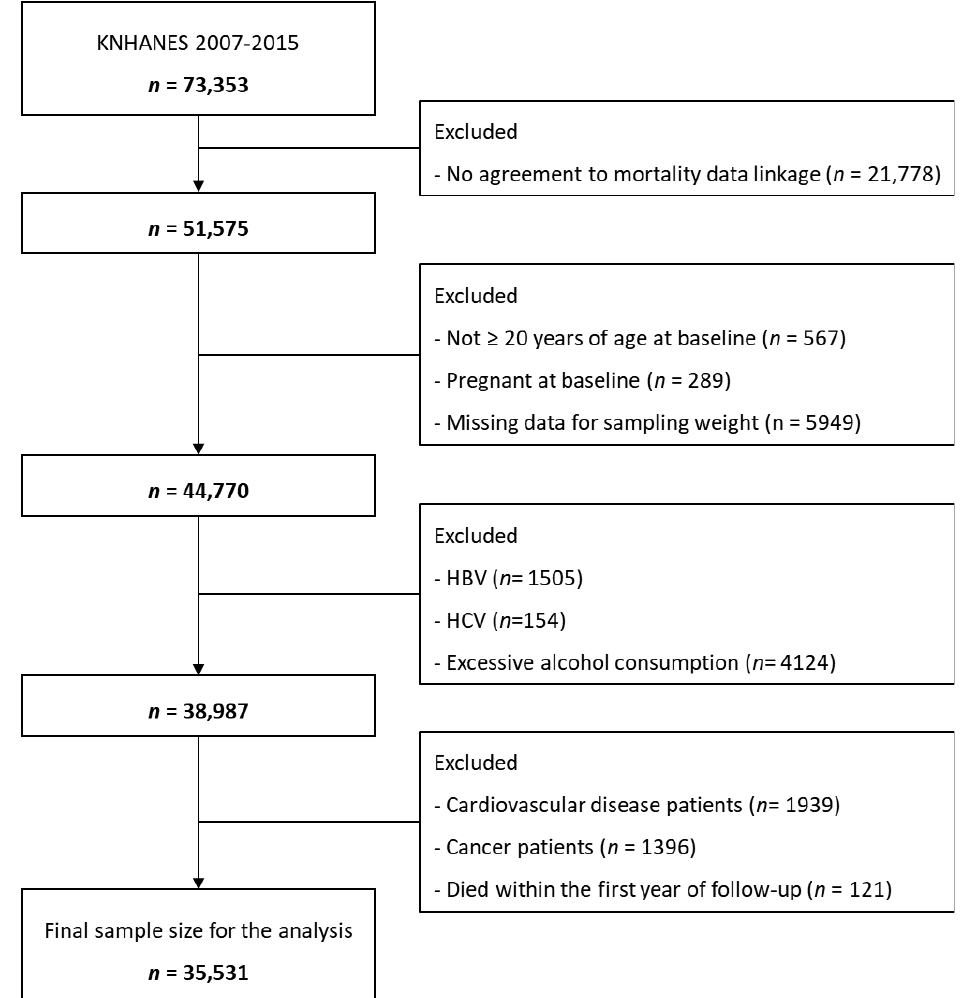
Figure 1. Flow diagram of study population. Table 1. Baseline characteristics of the study participants with or without advanced liver fibrosis. Table 2. Association between advanced liver fibrosis and mortality according to NFS and